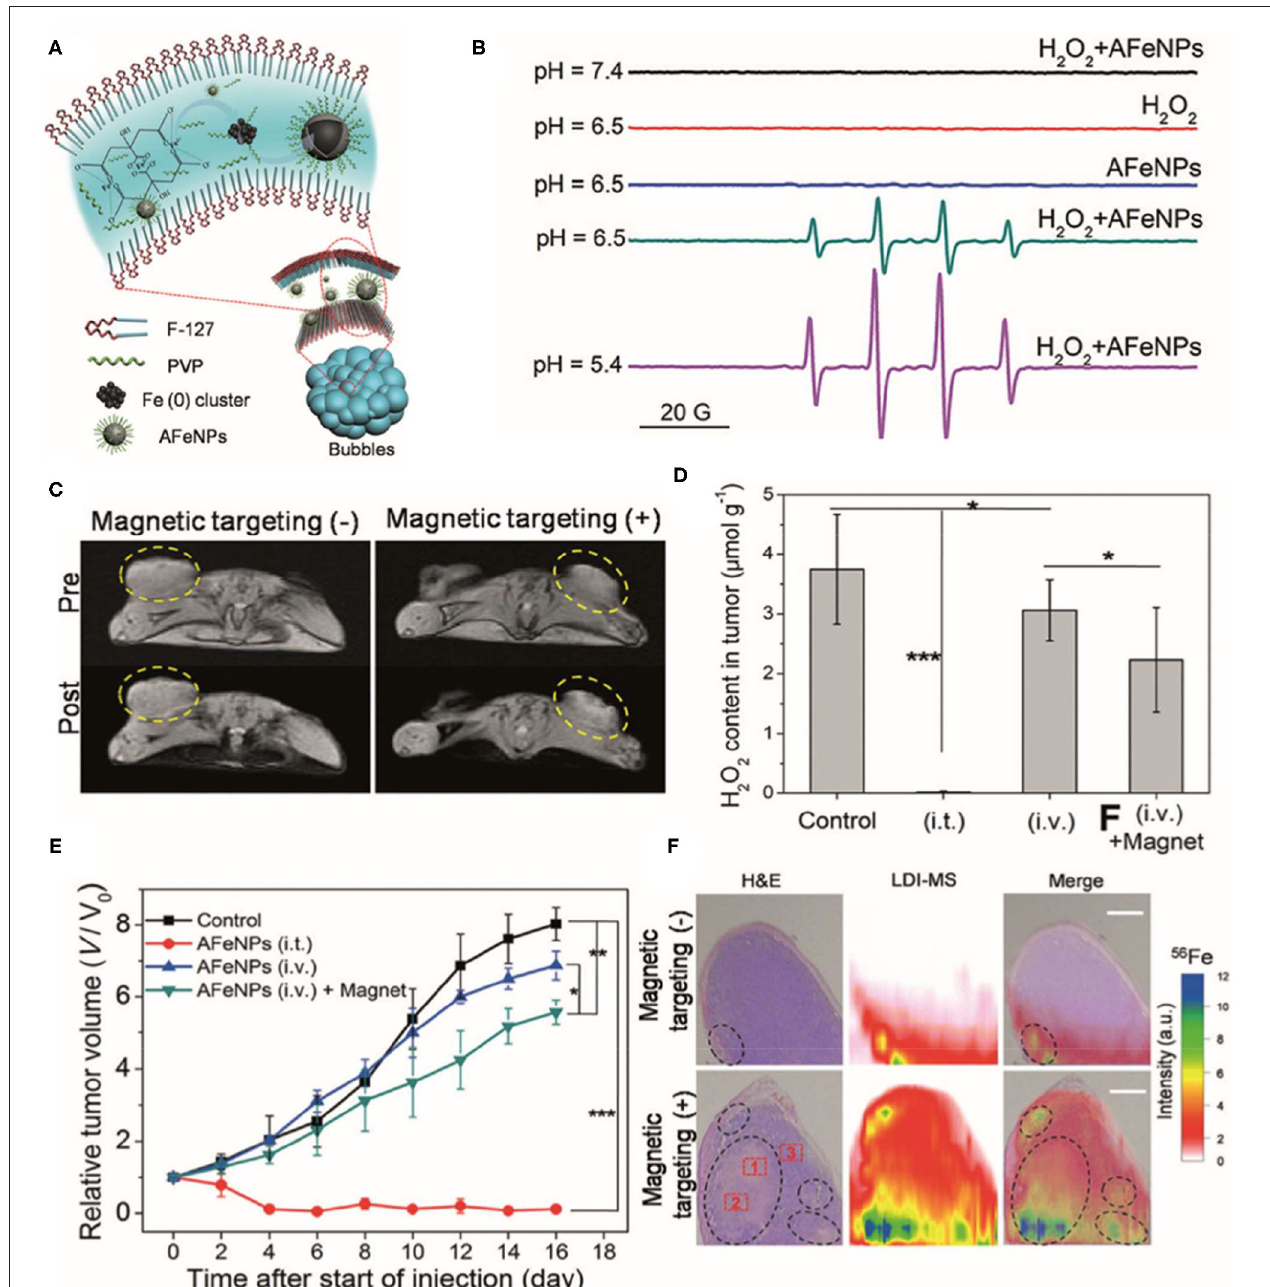
FIGURE 2 | (A) Schematic illustration of the synthetic procedure for amorphous iron nanoparticles (AFeNPs). (B) ESR spectra under different conditions using 5, 5-Dimethyl-1-pyrroline N-oxide (DMPO) as the spin trap. (C) T 1 -weighted MRI of 4T1 tumor-bearing mice before and after intravenous administration of AFeNPs with or without the assistance of external magnetic targeting. (D) The hydrogen peroxide (H 2 O 2 ) concentration within the tumor after either intratumoral or intravenous administration of AFeNP. (E) The tumor growth curve after different treatments. (F) H&E staining images and laser desorption/ionization mass spectroscopy (LDI-MS) 57 Fe 56 Fe mapping images of the tumor tissue after the intravenous administration of AFeNP with or without magnetic targeting guidance. Reproduced with permission from Zhang et al. (2016). Copyright (2016) Wiley-VCH. * p < 0.05, ** p < 0.01, *** p < 0.001.